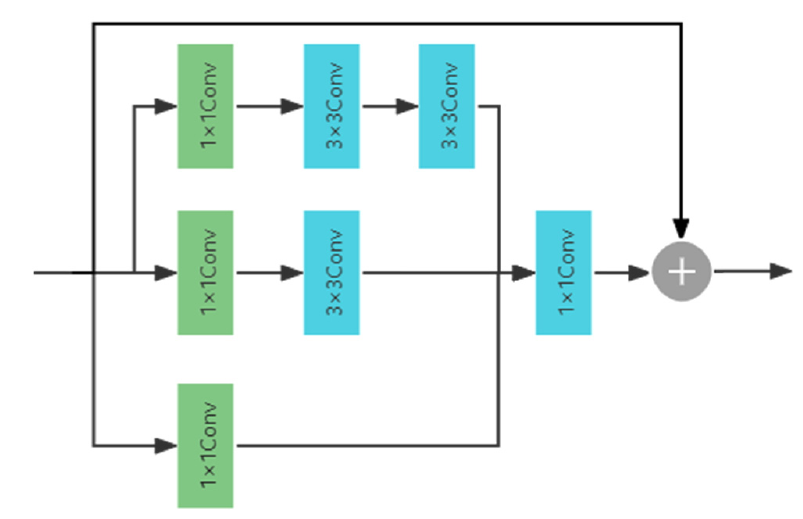
Figure 3. Inception-ResNet-A module structure, + stands for residual connection.